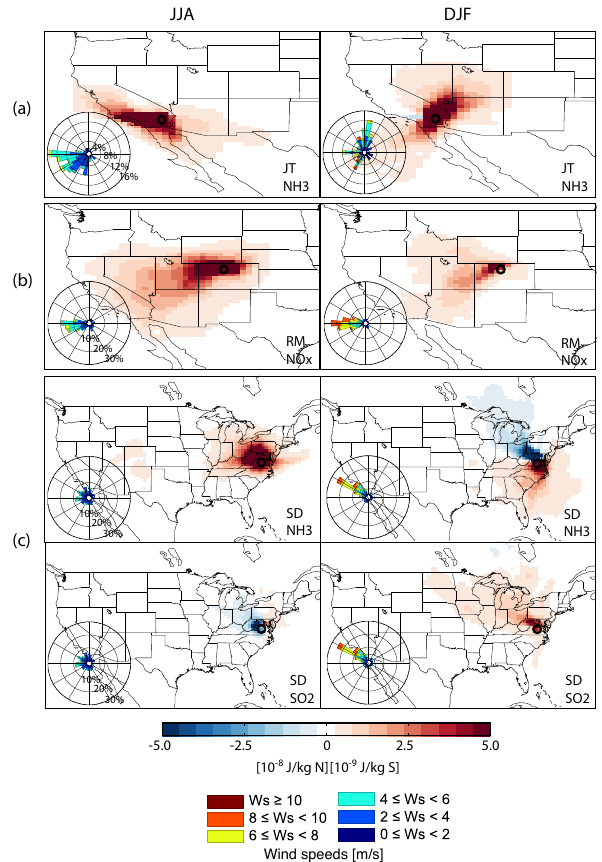
Figure 8. Efficiencies of impacts on Nr deposition showing cost function ( J p ) change per kg N or kg S emission for the tracer and season indicated in the plot. (a) Joshua Tree, (b) Rocky Mountain, (c) Shenandoah national parks. Wind-roses for each site show frac- tion of wind frequencies based on daily surface winds during the